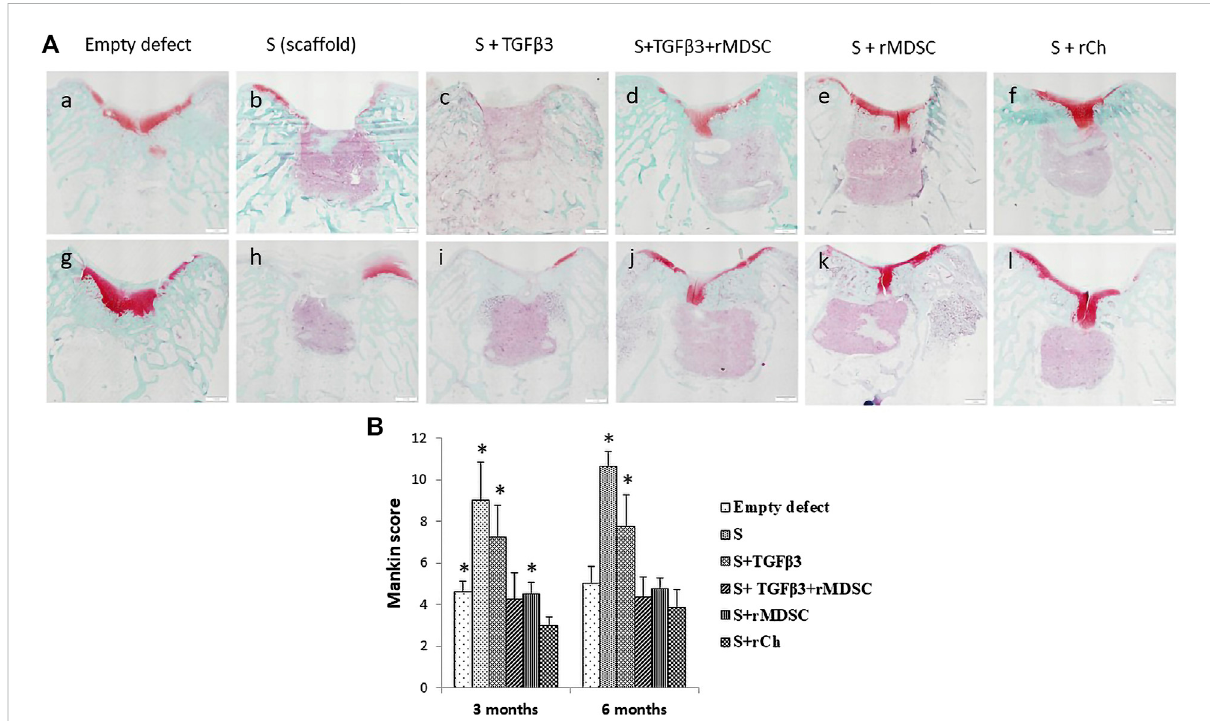
FIGURE 5 Safranin O staining of cartilage defects in different treatment groups after 3 (A – F) and 6 (g, h, i, j, k, and l) months (A) . Evaluation of cartilage healing according to the Mankin histological grading scale (B) . Scale bar-1 mm. Results are presented as mean ± standard deviation. * represents p -value < 0.05 Sc with other scaffolds, E, S, St, and Sm scaffolds at 3 months. In addition, the p -value < 0.05 represents a statistically signi fi cant difference compared to Sc with S and St scaffolds at 6 months. S, scaffold; TGF β 3, transforming growth factor-beta 3; rMDSCs, rabbit muscle- derived stem cells; rCh, rabbit chondrocyte. Abbreviations of the scaffolds (E, S, St, Stm, Sm, and Sc) are described in Section